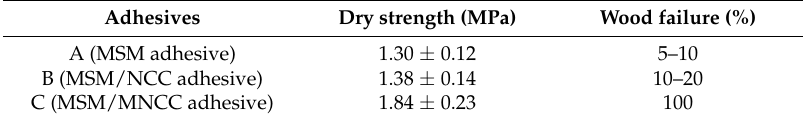
Table 1. Dry strength and wood failure of plywood bonded by the soybean meal-based adhesives.